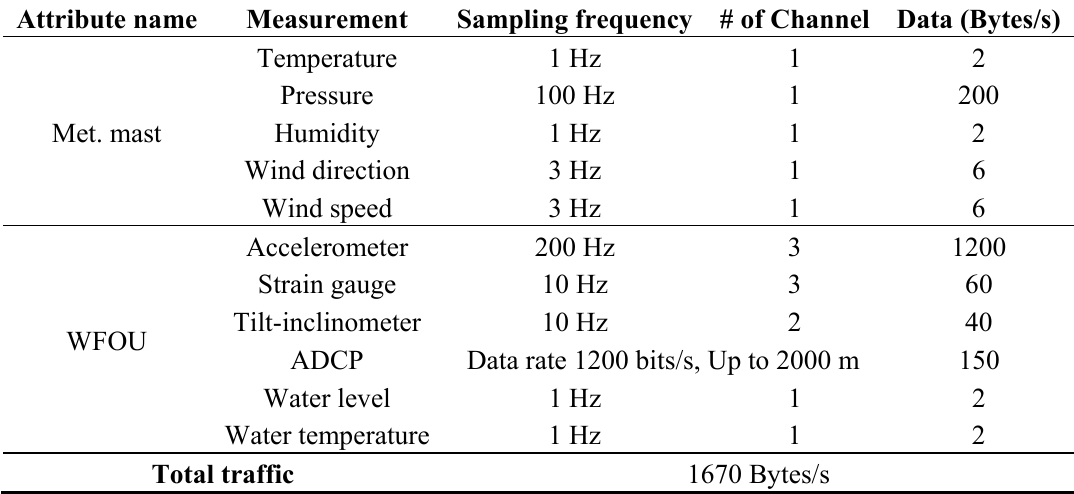
Table 7. Measuring requirements for sensor data (meteorological